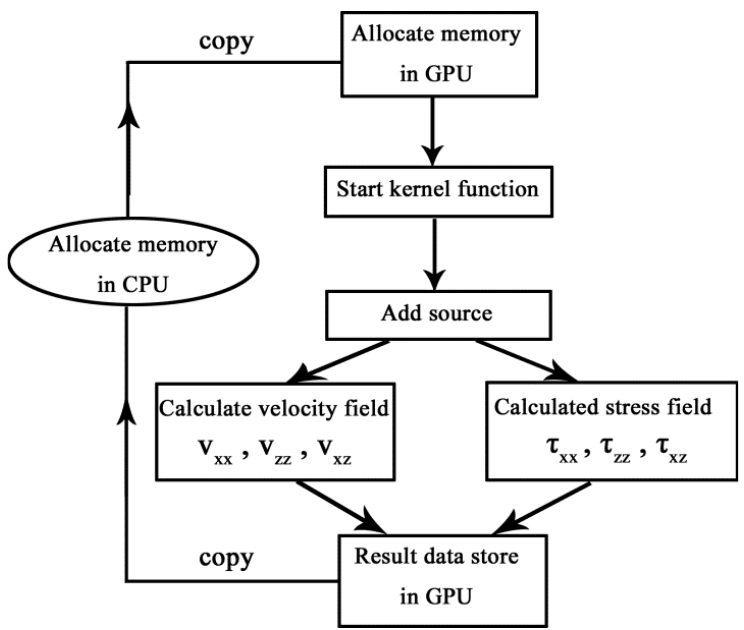
Figure 1. Graphics-processing unit (GPU) parallel-computing progress based on computer unified device architecture (CUDA) platform.